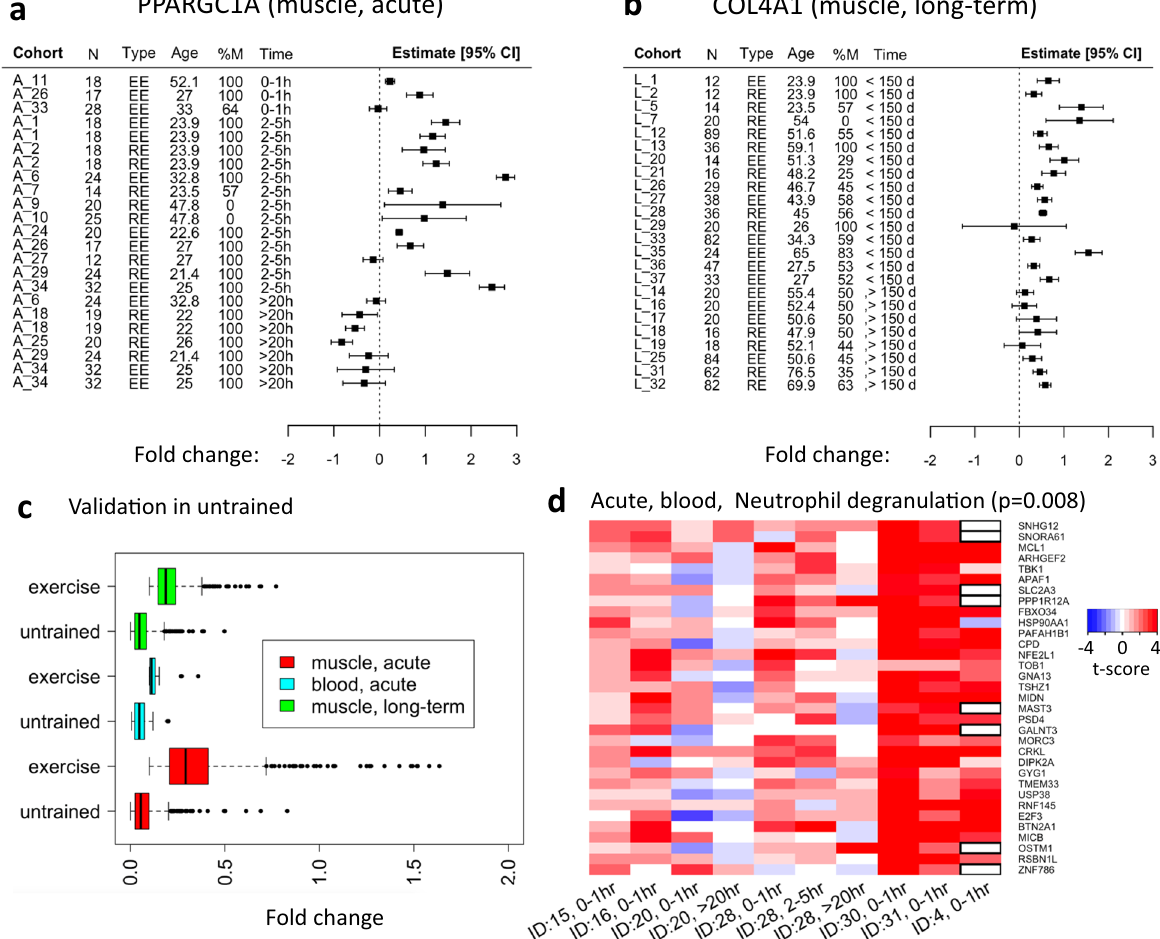
Fig. 3 Properties of the meta-analysis results. a Forest plot of the effect sizes of PPARGC1A in acute muscle cohorts. Upregulation appears primarily in the 2 – 5 h time window and is consistent for both endurance and resistance training. b Forest plot of the effect sizes of COL4A1 in the long-term muscle cohorts. Upregulation appears consistently across the cohorts. a – b Rows represent the 95% con fi dence interval of a fold-change of a cohort in a given time point. Thus, in each interval the center represents the fold-change estimate and the error bars are proportional to the fold-change standard error. Cohort: the ID given to the cohort in this study (see Supplementary Data 1 for details), N: sample size, Type: exercise type, RE: resistance exercise, EE: endurance exercise, Age: mean age in cohort, %M: percent of males in cohort, Time: the time window in hours. Note that a cohort can have multiple rows with the same time window and different fold-changes (e.g., if a study measured both 2 h and 4 h then both time points will be assigned 2 – 5 h). c The differential expression effects of our selected genes is unique to exercise. Colors represent the different meta-analysis types in the study. For each meta-analysis the effect sizes of our selected genes are presented, once for the exercise cohorts and once for the untrained cohorts. All paired two-sided Wilcoxon rank sum tests were signi fi cant at p < 1 × 10 − 07 (acute exercise, muscle: 537 genes, p = 1.5 × 10 − 88 ; long-term training, muscle: 441 genes, 3.1 × 10 − 68 ; acute exercise, blood: 37 genes, p = 6.2 × 10 − 08 ). Each boxplot shows the median, and fi rst and third quartiles. The whiskers extend from the hinge to the largest and lowest values, but no further than 1.5 *(the inter-quantile range). d Heatmap of the upregulated genes selected in the acute blood meta-analysis. Columns represent cohorts, with sampling time point post exercise listed for each, and rows are genes. Boxed cells indicate missing values for that particular gene and cohort. All acute blood studies measured the response to endurance exercise in up to 3 h after the bout ended. Source data are provided as a Source Data fi